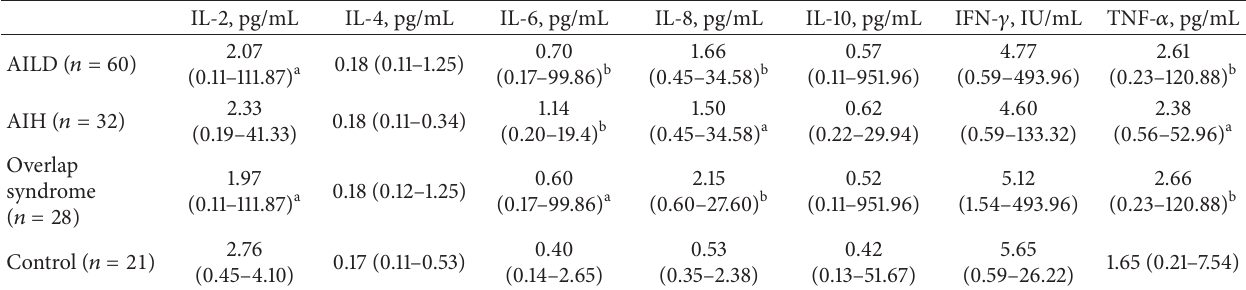
Table 2: Serum circulating levels of cytokines in patients with AILD and in healthy controls. Numbers are presented as median